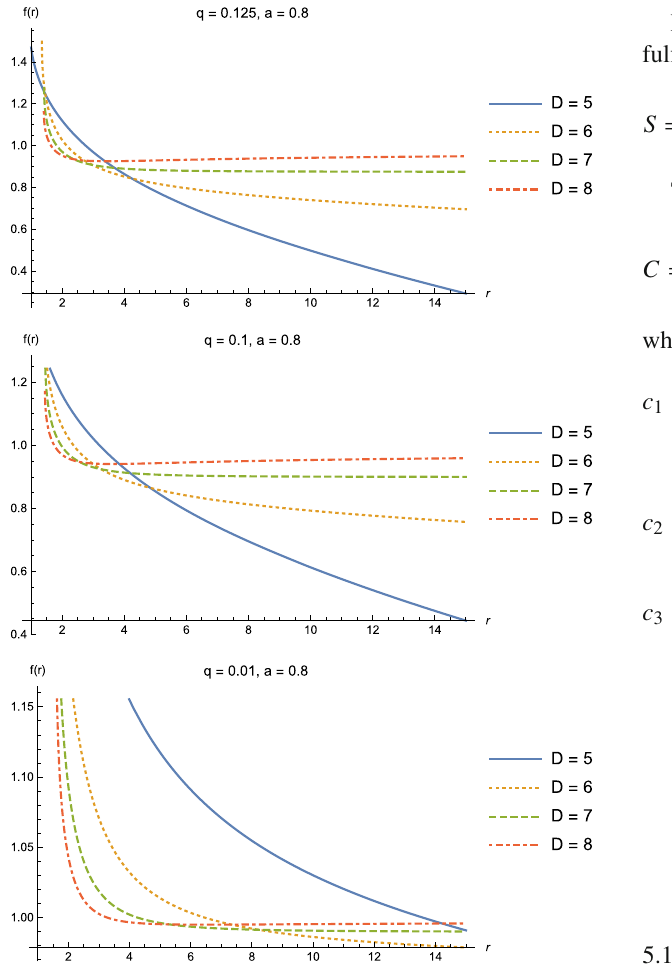
Fig. 4 Thefunction f ( r ) intheGauss–Bonnetgravityfor ω q = − 2 / 3, M = 1 and α 2 =